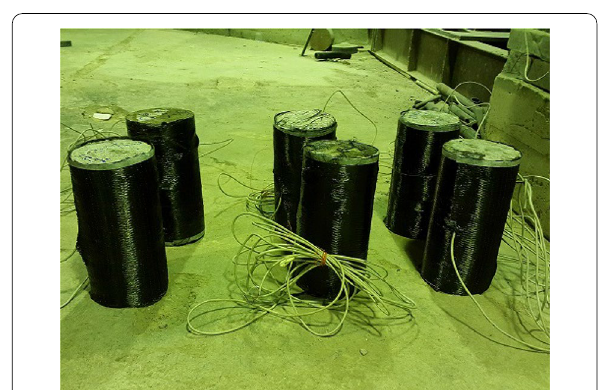
Fig. 7 CFRP fibers and confined specimens ready for testing compressive strength.